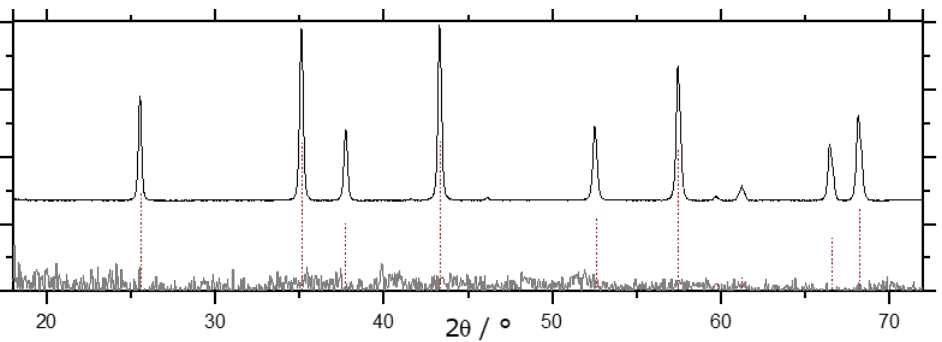
Figure 8. Superimposed mercury intrusion data of samples MCH-w ( left ) and MCH-o ( right ), calcined at 600 °C (gray) and 1200 °C (red), respectively. NB: For better legibility, scales are adjusted to the requirements of the data.